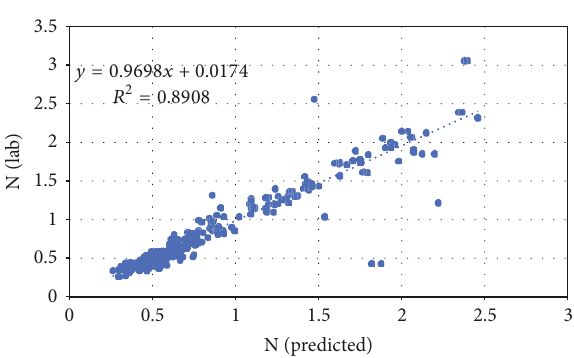
Figure 4: Linear regression relationship between laboratory refer- encemethodsandNIRS-predictedvaluesforN( 𝑅 2 = 0.89 )ofwinter and spring canola from 2011 on a dry weight basis.